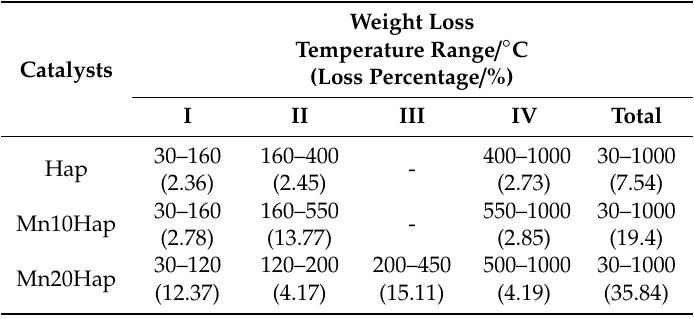
Table 2. Thermogravimetric